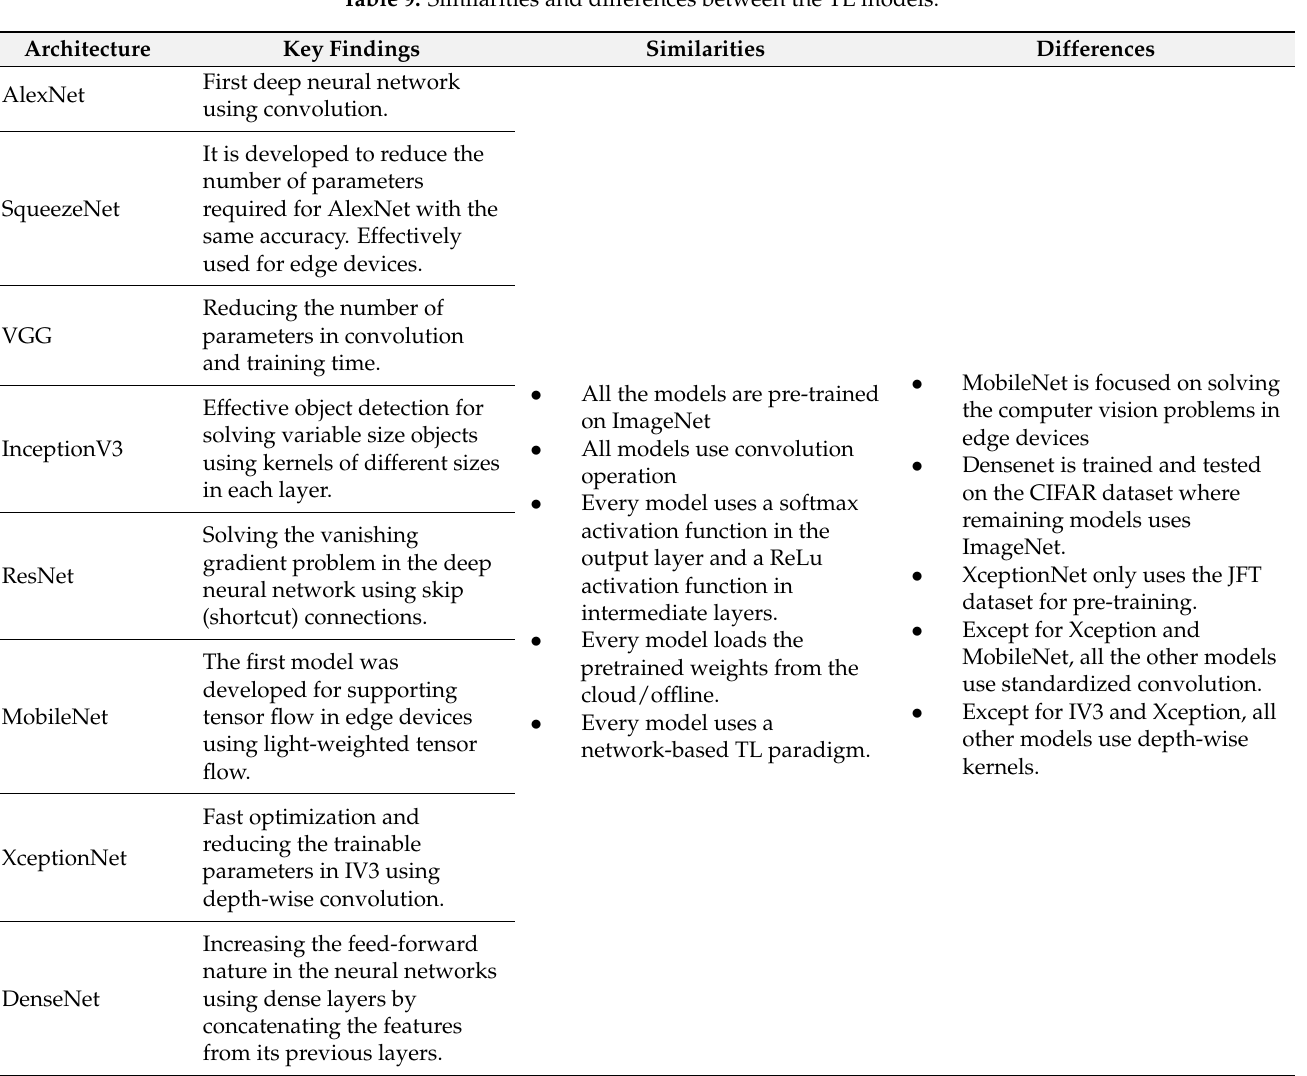
Table 9. Similarities and differences between the TL